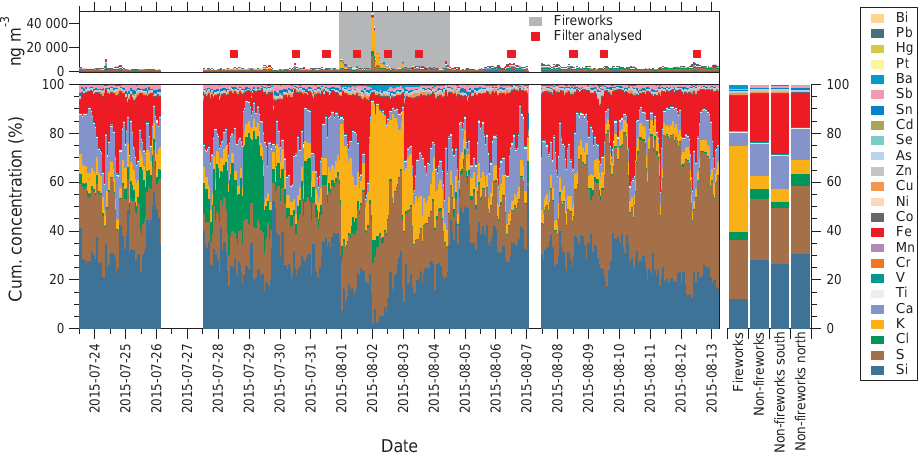
Figure 1. Main panel: relative amount of analysed elements by Xact 625 during the field campaign. Top panel: absolute concentrations, stacked. The grey shaded area denotes the fireworks period. The red squares mark the days when 24h filters were analysed and used for comparisons in this study. Bottom panel: relative cumulative elemental concentrations, stacked. Right panel: average relative contributions (in%) of elements for the fireworks period, the non-fireworks period, and the south and north sectors during the non-fireworks